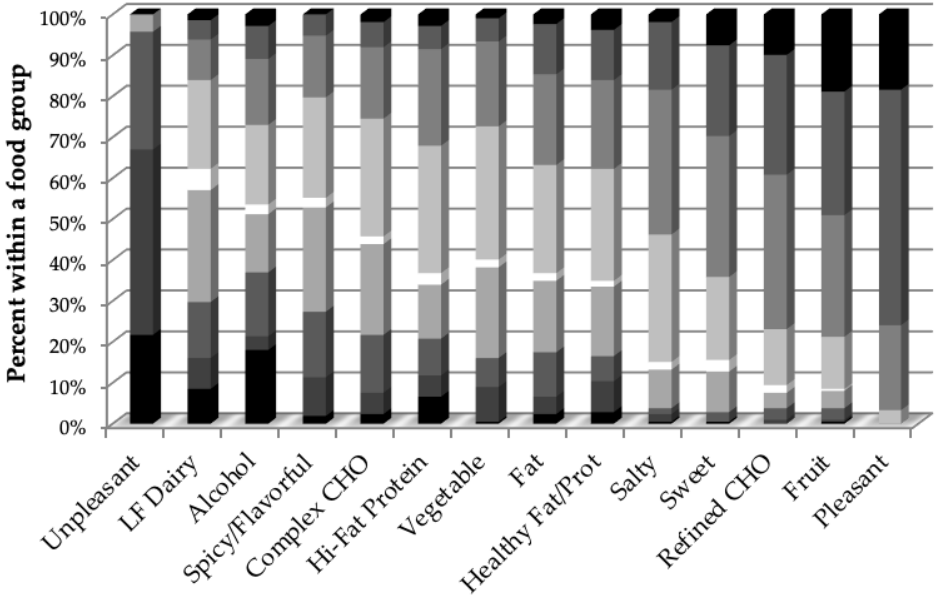
Figure 2. Percent of young adults within a food group from Table 1 who reported like (above the white neutral rating) and dislike (below the white neutral rating), partitioned into 25th percentiles, with the darker the shading, the stronger the liking or disliking. The food groups are ordered from least to most liked bracketed by unpleasant and pleasant non-food sensations. (CHO = carbohydrate, LF = low-fat)